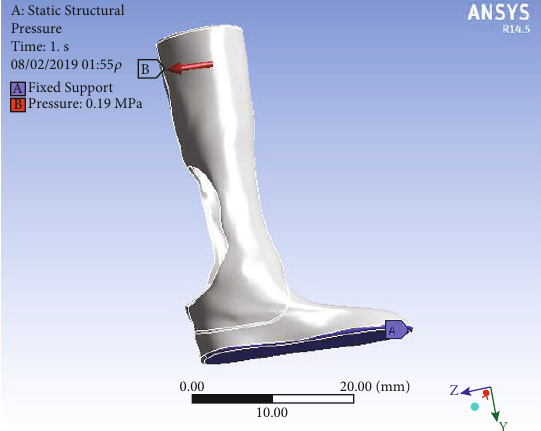
Figure 6: Prosthetic displacement condition and applied forces.